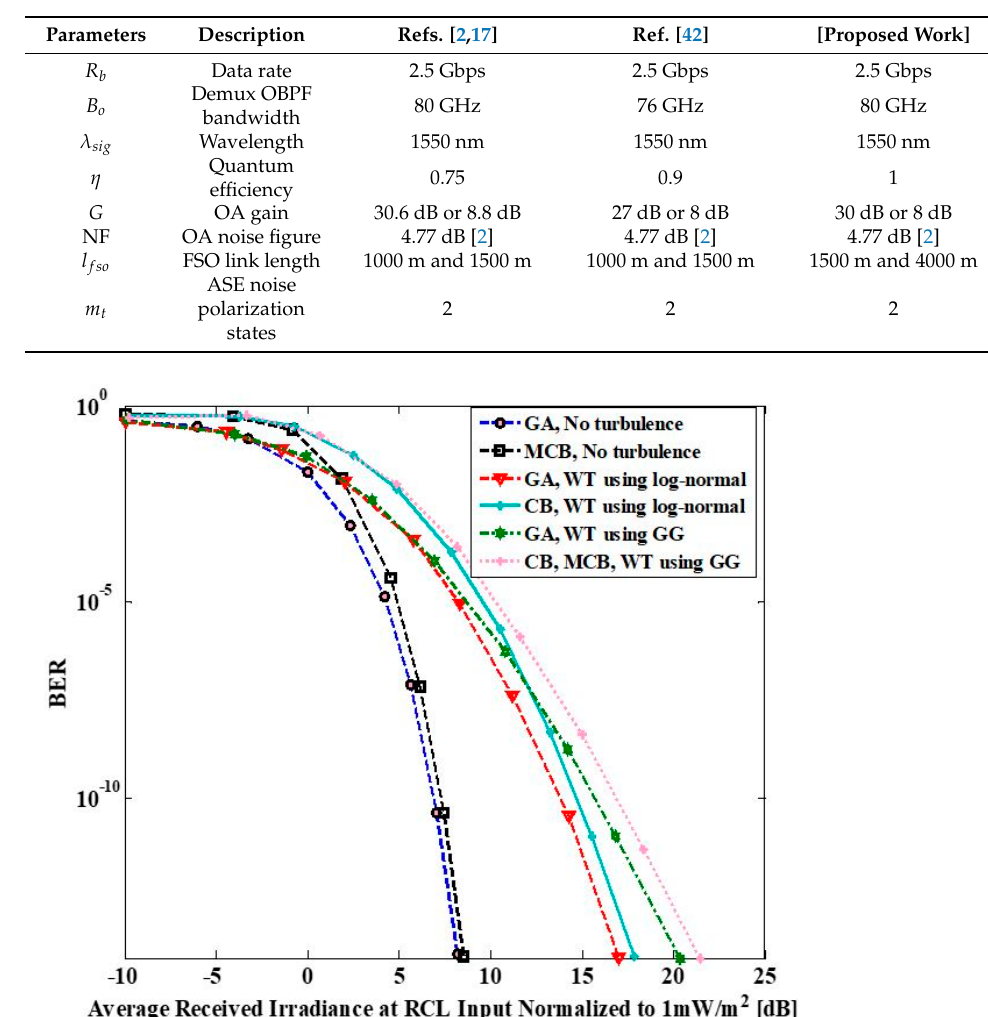
Table 1. System parameters used for calculations in [2,17,42] and [Proposed work].